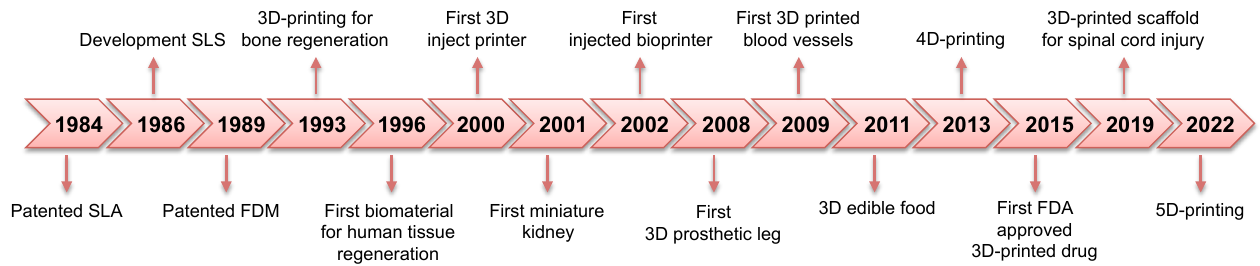
Figure 1. Additive manufacturing history and milestones in biomedical field. 58